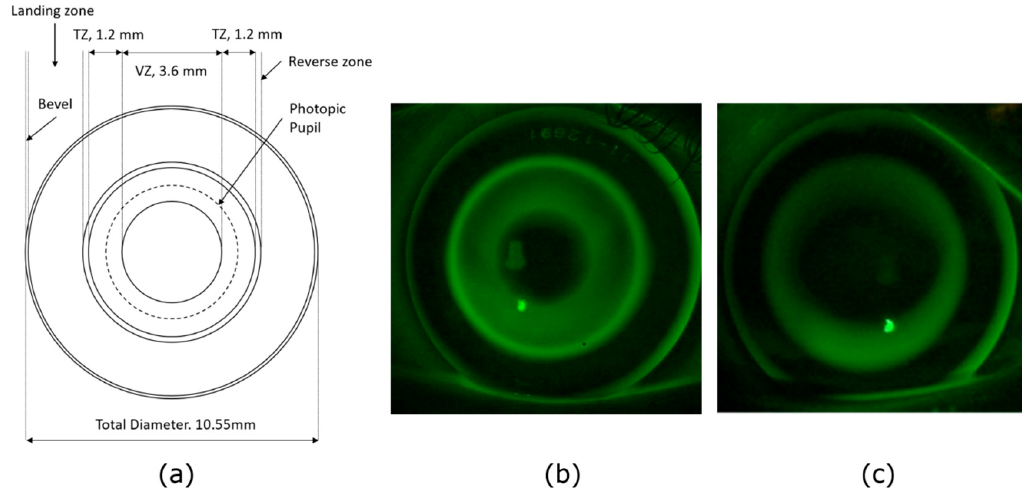
Figure A1. Details of the multifocal orthokeratology (MOK) Lens. ( a ) Diagram of the multifocal orthokeratology (MOK) lens. Vision correction zone (VZ): Diameter (MOK: 3.6 mm; OK: 6.00 mm), back surface radius based on topography and amount of myopia to be corrected. Treatment zone (TZ) annulus width 1.2 mm. TZ power: +2.50 D relative to VZ power. Reverse zone: Individually made based on topography to connect TZ with the landing zone. Landing zone: Based on topography. The landing zone was needed to achieve good